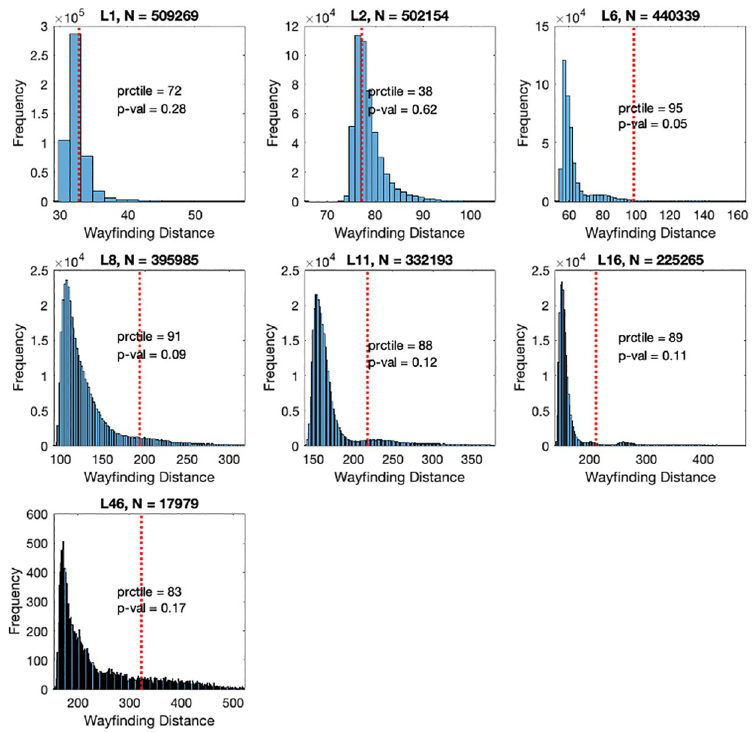
Fig 5. Histogram of distance metrics of patient B individually plotted against distance metrics of control population. ’N’ is the control sample size. The red dashed vertical line corresponds to the patient’s performance. Prctile is the percentile of the patient’s performance in the control distribution. P-value is the inverse (number of controls with worst performance / N).